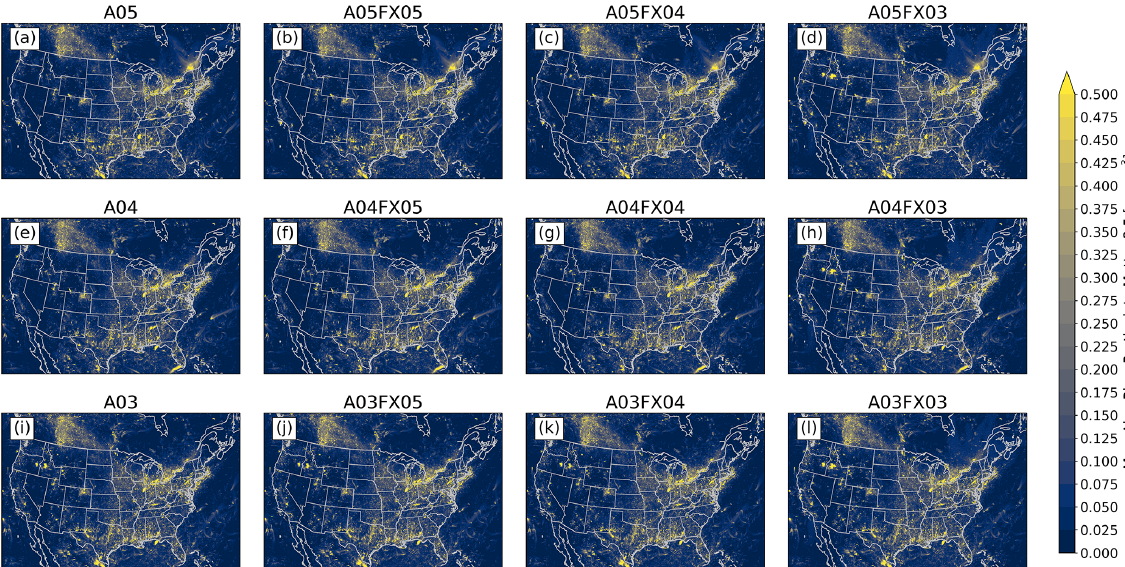
Figure 7. Maximum absolute bias (versus the orig simulation) for PM 2 . 5 calculated from hourly output for all simulations and cases.